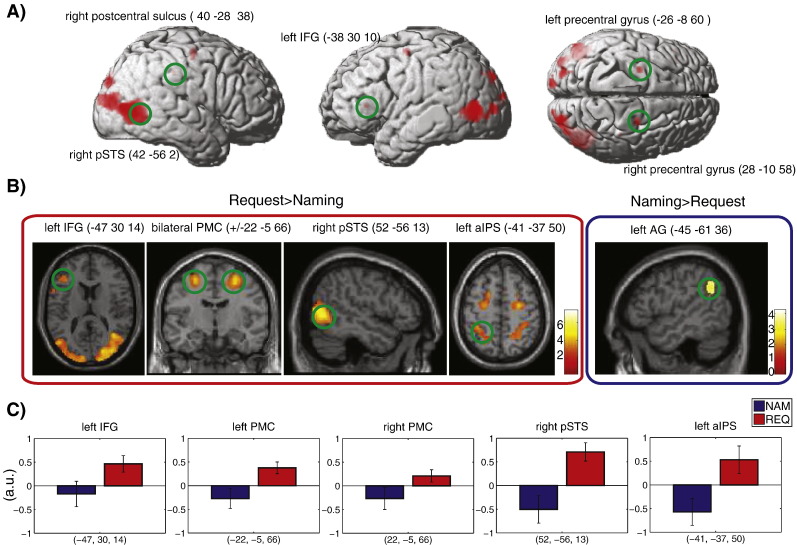
Main results. A. Whole-brain analysis activation for the contrasts “Request > Naming” (shown in red) and “Naming > Request” (in blue), rendered at p < 0.05 FDR-corrected. B. ROI analysis, small volume corrected (SVC) at FWE p < 0.05, rendered at p < 0.01 (unc.), k = 10. C. Signal extraction ROI analysis. pSTS — posterior superior temporal sulcus, IFG — inferior frontal gyrus, aIPS — anterior intraparietal sulcus, vmPFC — ventromedial prefrontal cortex, AG — angular gyrus, PMC — premotor cortex.